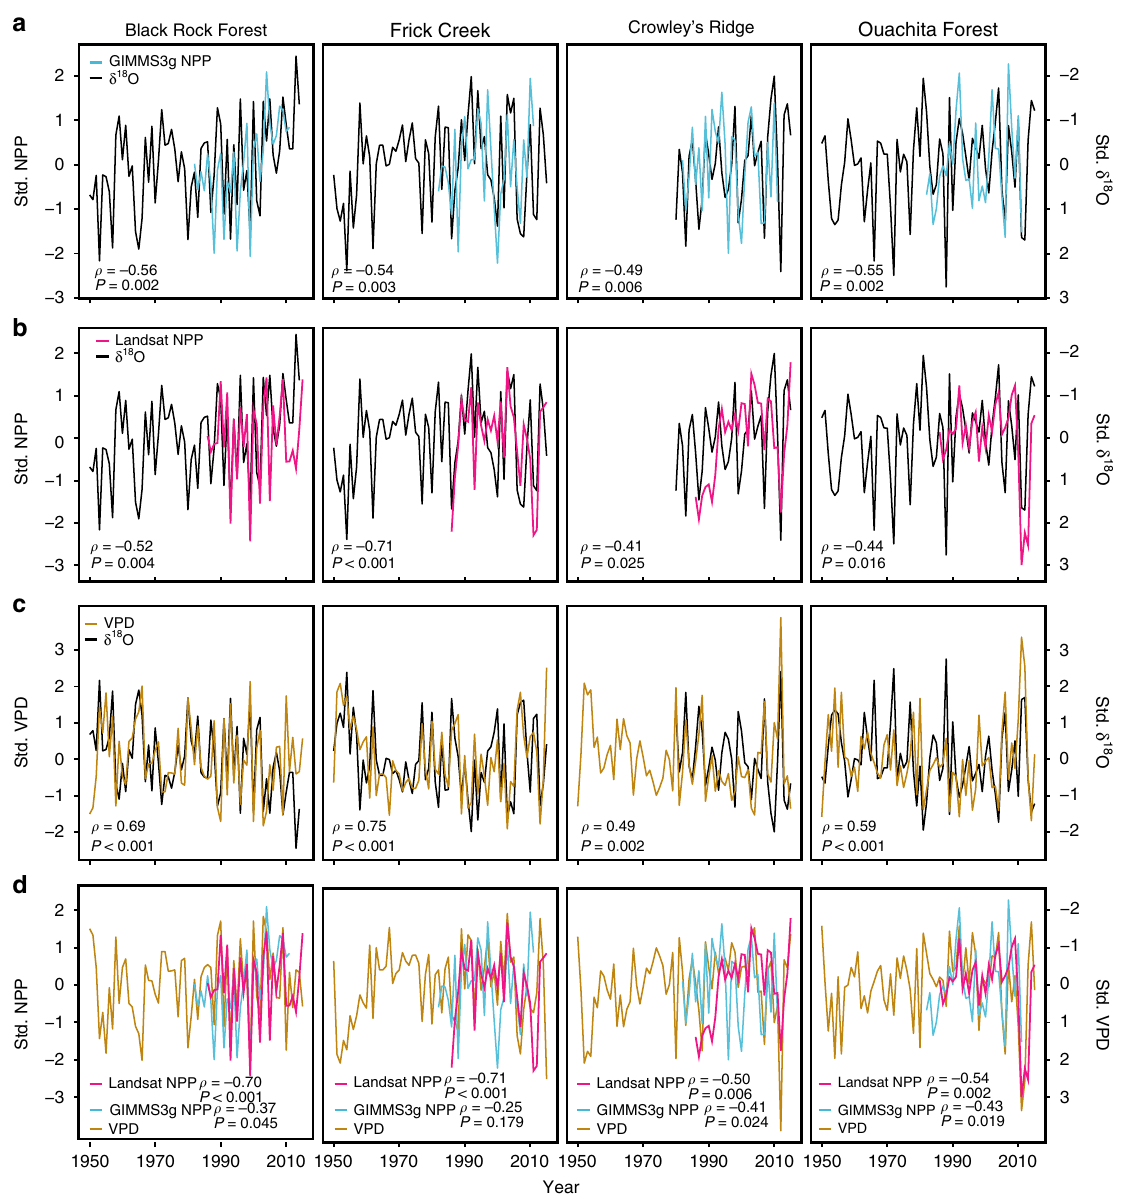
Fig. 3 Tree-ring δ 18 O, GIMMS3g NPP, Landsat NPP, and vapor pressure de fi cit (VPD) time series at the study sites. Time series were standardized (Std.) and correlated to each other for the overlapping period. Tree-ring δ 18 O plotted against GIMMS3g NPP ( a ), Landsat NPP ( b ) and summer (June – August) VPD ( c ). VPD plotted against GIMMS3g NPP and Landsat NPP ( d ). Correlations and their signi fi cance are indicated by Spearman ’ s rank correlation coef fi cient ( ρ ) and P -value ( P ). Note the inverse y-axis for Std. δ 18 O and VPD in a , b , and